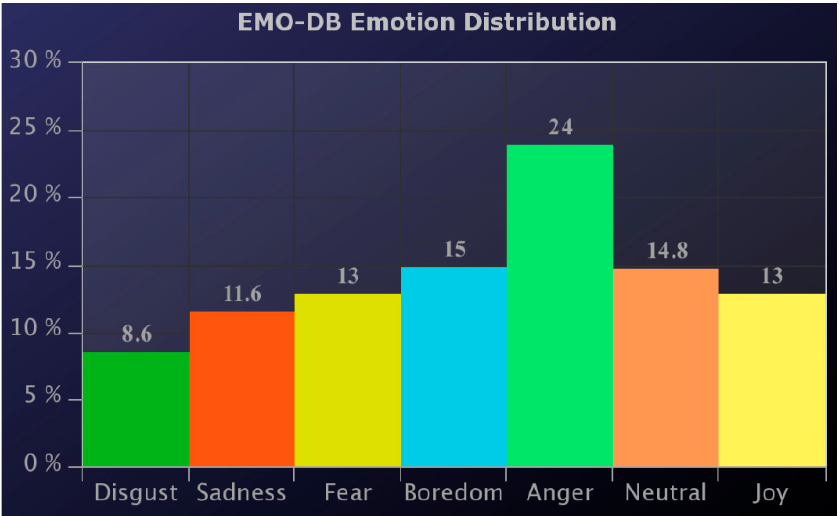
Figure 7. EMO-DB emotion data distribution.